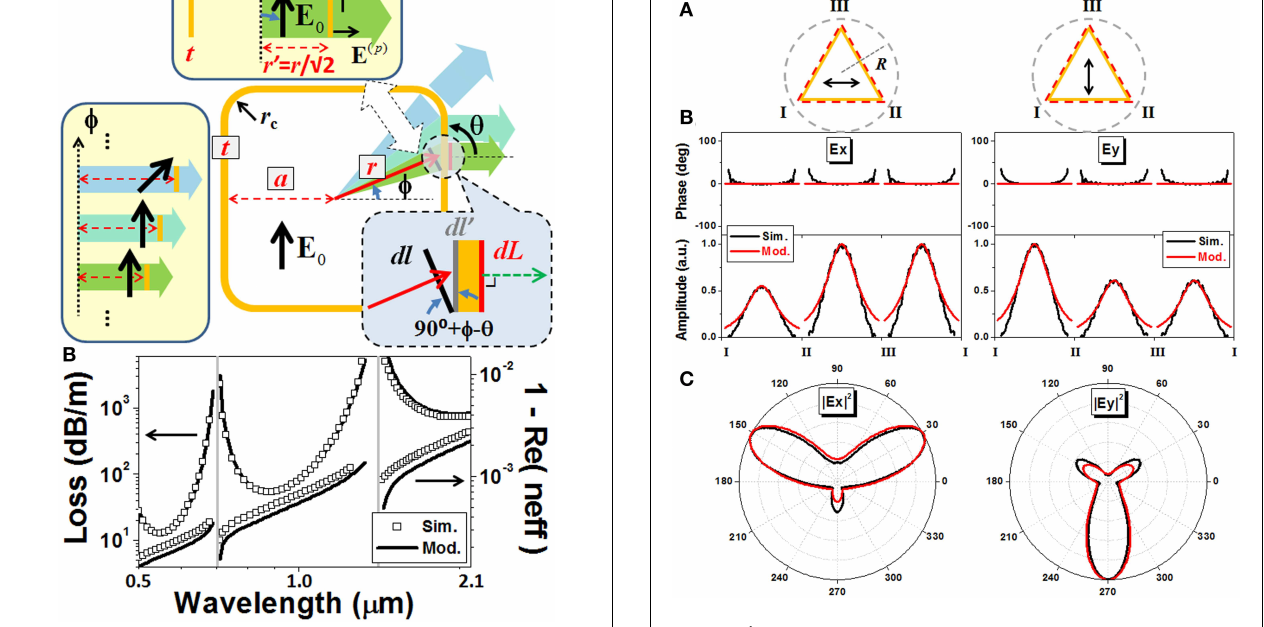
FIGURE 5 | (A) Schematics of a single-wall triangle ARF and two orthogonal polarizations. (B) Semi-analytically modeled (the red lines) and numerically FIGURE 4 | (A) Geometry transformation from a square ARF to a series of simulated (the black lines) electric field amplitudes and phases at the slab waveguides. (B) Semi-analytically modeled (the solid lines) and outermost boundary (0.5 µ m offset outwards). (C) Modeled (the red lines) and numerically simulated (the hollow squares) attenuations and propagation simulated (the black lines) electric field intensities at a far-distance circle R . a constants of the fundamental core mode as a function of the wavelength = 9.76 µ m, t 0.67 µ m, R 90 µ m, and λ 0 0 . 91 µ (logarithmic scale). a 9.76 µ m, t 0.67 µ m, and r c 2 . 5 µ m. = = = = = =